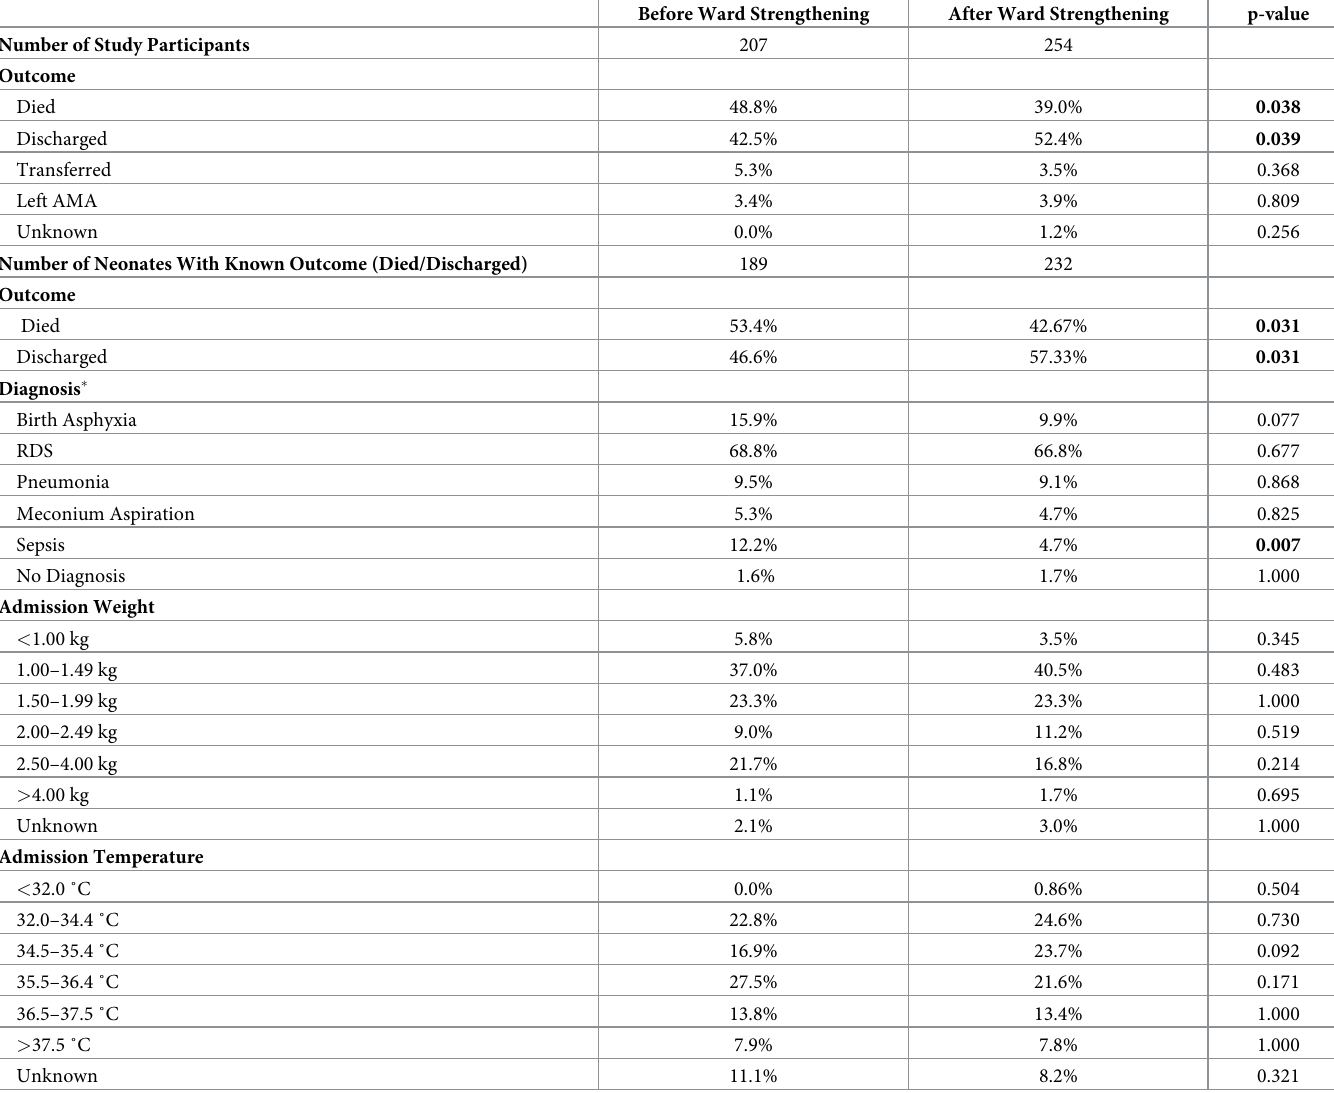
Table 3. Patient data for neonates treated with CPAP for one year before and after ward-strengthening program at district-level hospitals in Malawi